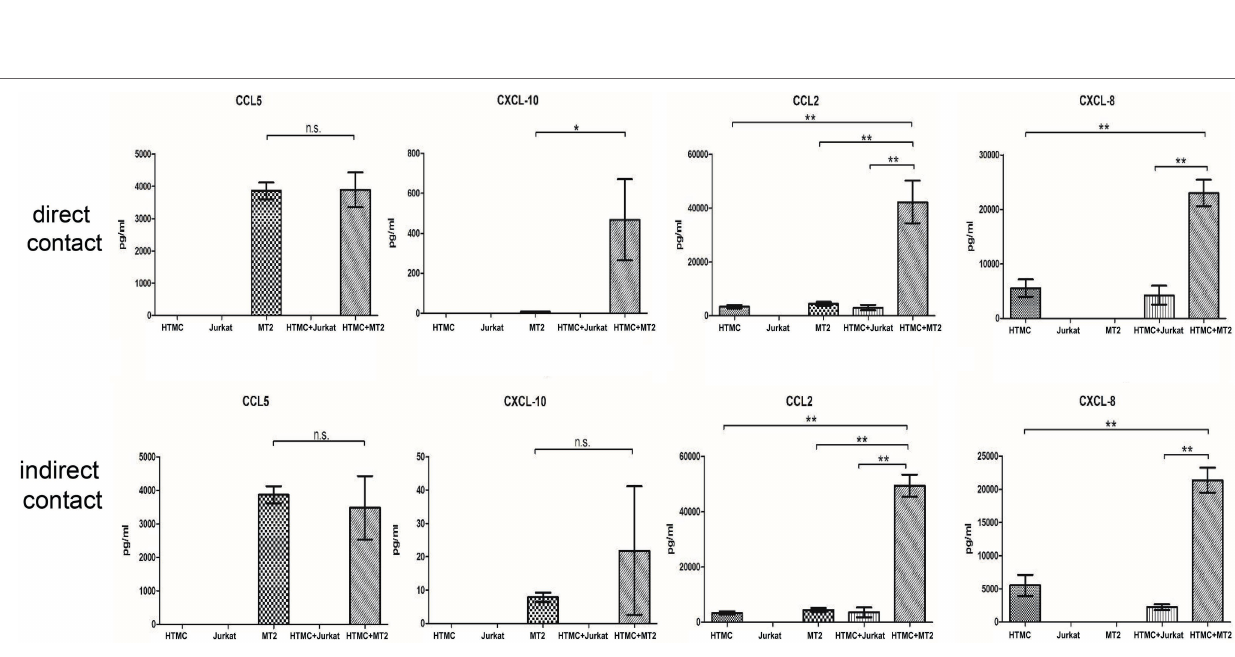
FIGURE 4 | Chemokines secreted by HTMCs, MT-2 cells, Jurkat cells, and HTMCs co-cultured with MT-2 or Jurkat cells under conditions of direct/indirect contact for 48 h. After co-culture with MT-2 cells, levels of the chemokines CCL10, CCL2, and CXCL8 increased significantly. After co-culture with MT-2 cells using the Transwell system, levels of the chemokines CXCL10, CXCL8 (IL-8), and CCL2 increased significantly. Data are taken from three independent biological experiments. Error bars represent standard deviation (units: pg./ μ l; * p < 0.05; ** p < 0.01; n.s., not